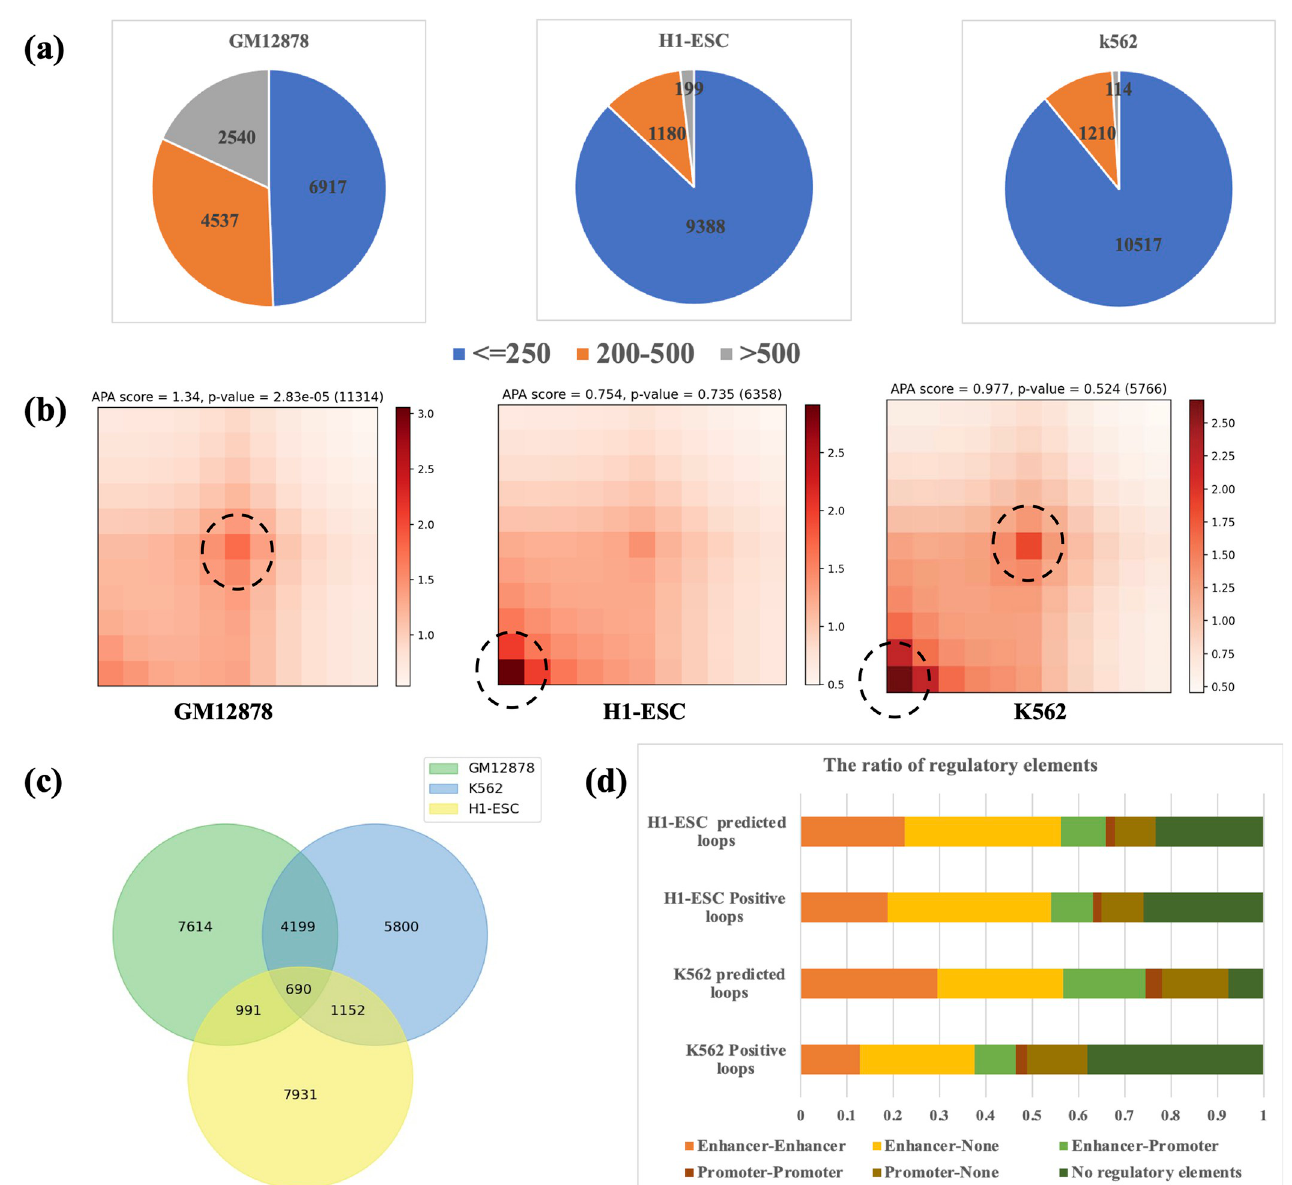
Fig 6. Comparison of chromatin loops among cell types. (a) Distance distribution of DLoopCaller identified chromatin loops from Hi-C contact maps by using CTCF ChIA-PET data after training on GM12878, H1-ESC, and K562 (replicate1) separately. (b) APA plots of identified chromatin loops in GM12878, H1-ESC, and K562 (replicate1). (c) Venn diagram of DLoopCaller identified chromatin loops determined by CTCF ChIA-PET experiments in GM12878, H1-ESC and K562 (replicate1). (d) The proportion of CTCF ChIA-PET interactions types for H1-ESC and K562. The proportion of identified chromatin loops types using CTCF ChIA-PET data after training for H1-ESC and K562